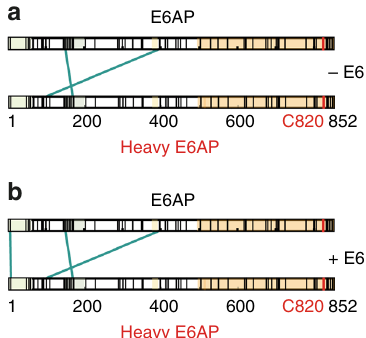
Fig. 2 SILAC-XL-MS reveals weak interactions between E6AP N-termini. Identi fi ed interlinks between two E6AP protomers (i.e., heavy and light version of E6AP). Shown are the interlinks in the absence ( a ) and presence of E6 ( b